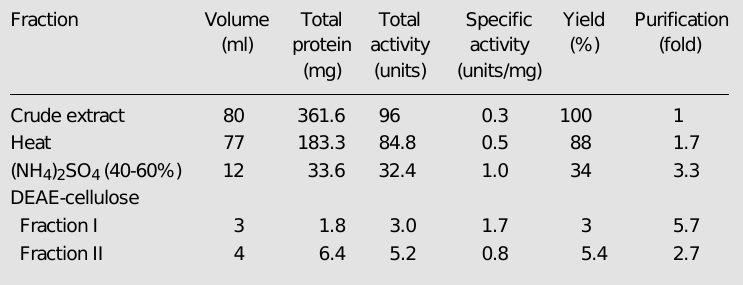
Table 2 - Partial purification of the constitutive alkaline phosphatases synthesized by the wild 74A strain of N. crassa grown in non-buffered high-Pi medium at 30 o C, supplemented with 44 mM sucrose as the carbon source and adjusted to pH 5.4. For details, see Material and